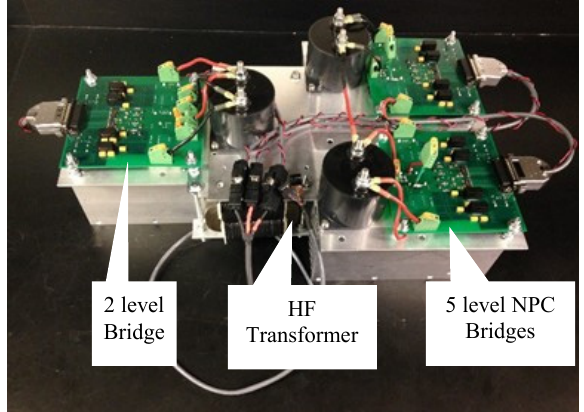
Figure 20. ML-DAB prototype hardware setup for laboratory